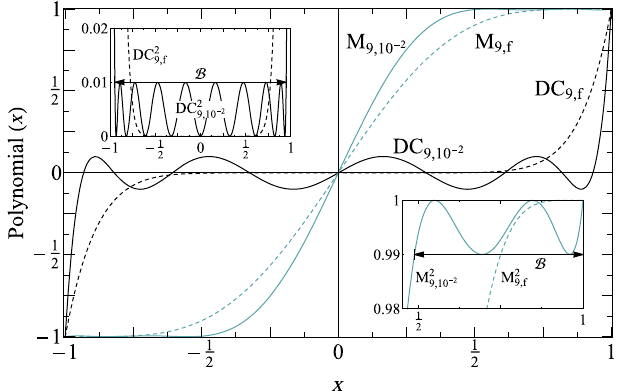
FIG. 1. DC (black lines) and M (teal lines) polynomials L; I L; I plotted for L ¼ 9 and target worst-case infidelity I ¼ 10 − 2 (solid lines) and I → 0 (dashed lines), indexed by f. The observed ripples are a generic feature of bandwidth-optimized polyno- mials, unlike those optimized for maximal flatness DC , M . The f f inset plots their squares and defines the bandwidth B in x